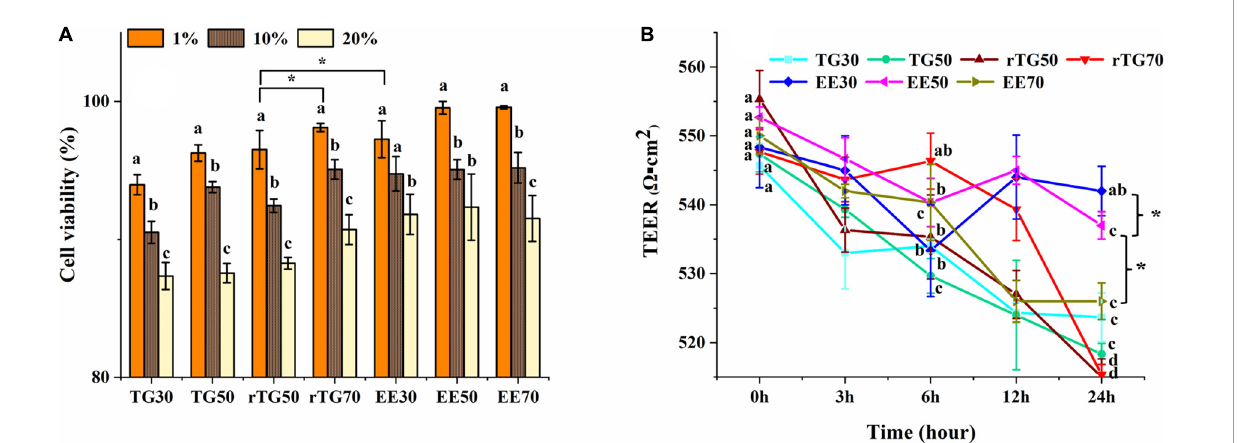
FIGURE4 Evaluation of the cell viability and the Caco-2 monolayer cell membrane model. (A) Cell viability when incubated with mixed micelles for 24 h at different concentrations (1, 10 and 20%, v/v). (B) Changes in TEER values of Caco-2 cell monolayer after adding mixed micelles (20% concentration, v/v) and incubating for 0, 3, 6, 12 and 24 h. Data represents mean ± SD ( n = 3). Different letters and * represent significant differences ( p <0.05).